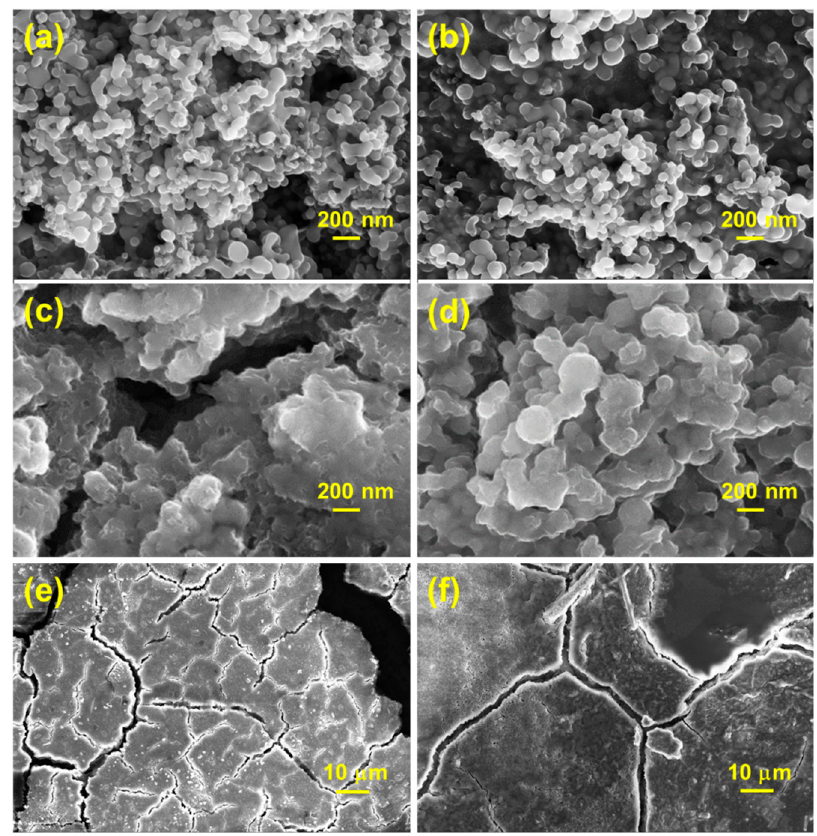
Figure 2. Morphology of a pristine ( a ) Si − XG − AB electrode, ( b ) Si@C − network electrode and after galvanostatic cycling in LiPF 6 /DMC at 0.2 C for 100 cycles, ( c , e ) Si − XG − AB, and ( d , f ) Si@C − network electrode.